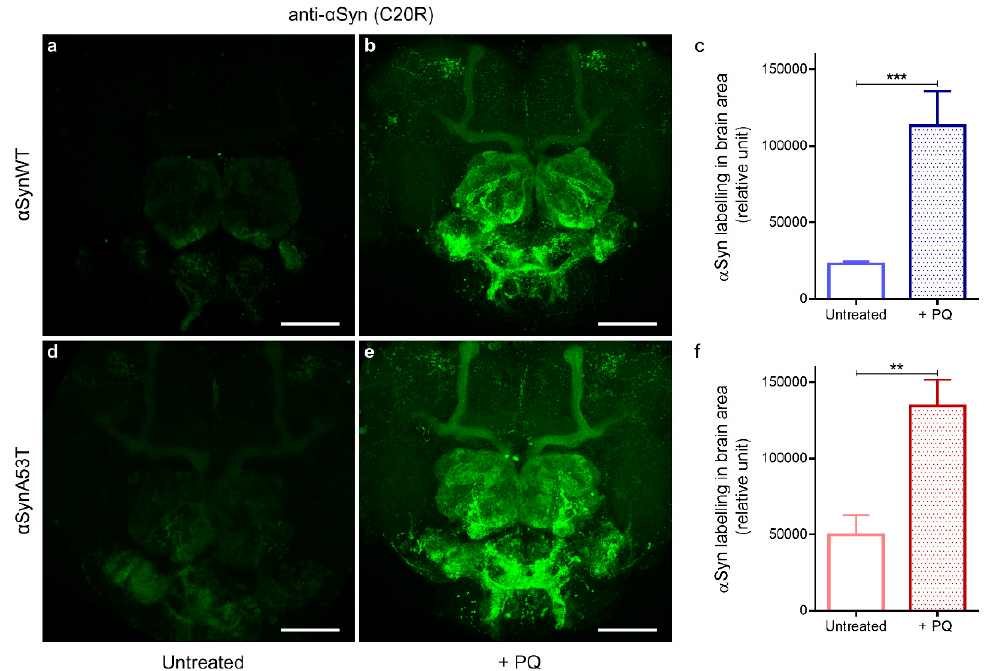
Figure 5. Chronic exposure to PQ causes α Syn accumulation in α Syn expressing flies. Representative immunofluorescence images of dissected brains stained with an anti- α Syn (C20R) antibody of α SynWT and α SynA53T expressing flies raised in control ( a , d ) or PQ supplemented medium ( b , e ) and analyzed at LT50. Images were projected from confocal Z-stacks acquired on confocal microscope. Scale bar, 30 µm. Quantifications showed a significant increase in α Syn detection be- tween flies exposed to PQ and untreated flies for α SynWT (n = 6) ( c ) and α SynA53T (n = 9) ( f ). Data are shown as mean with standard deviation. P -values of the group differences were calculated using t test (*** p = 0.0003 and ** p = 0.0059, respectively).